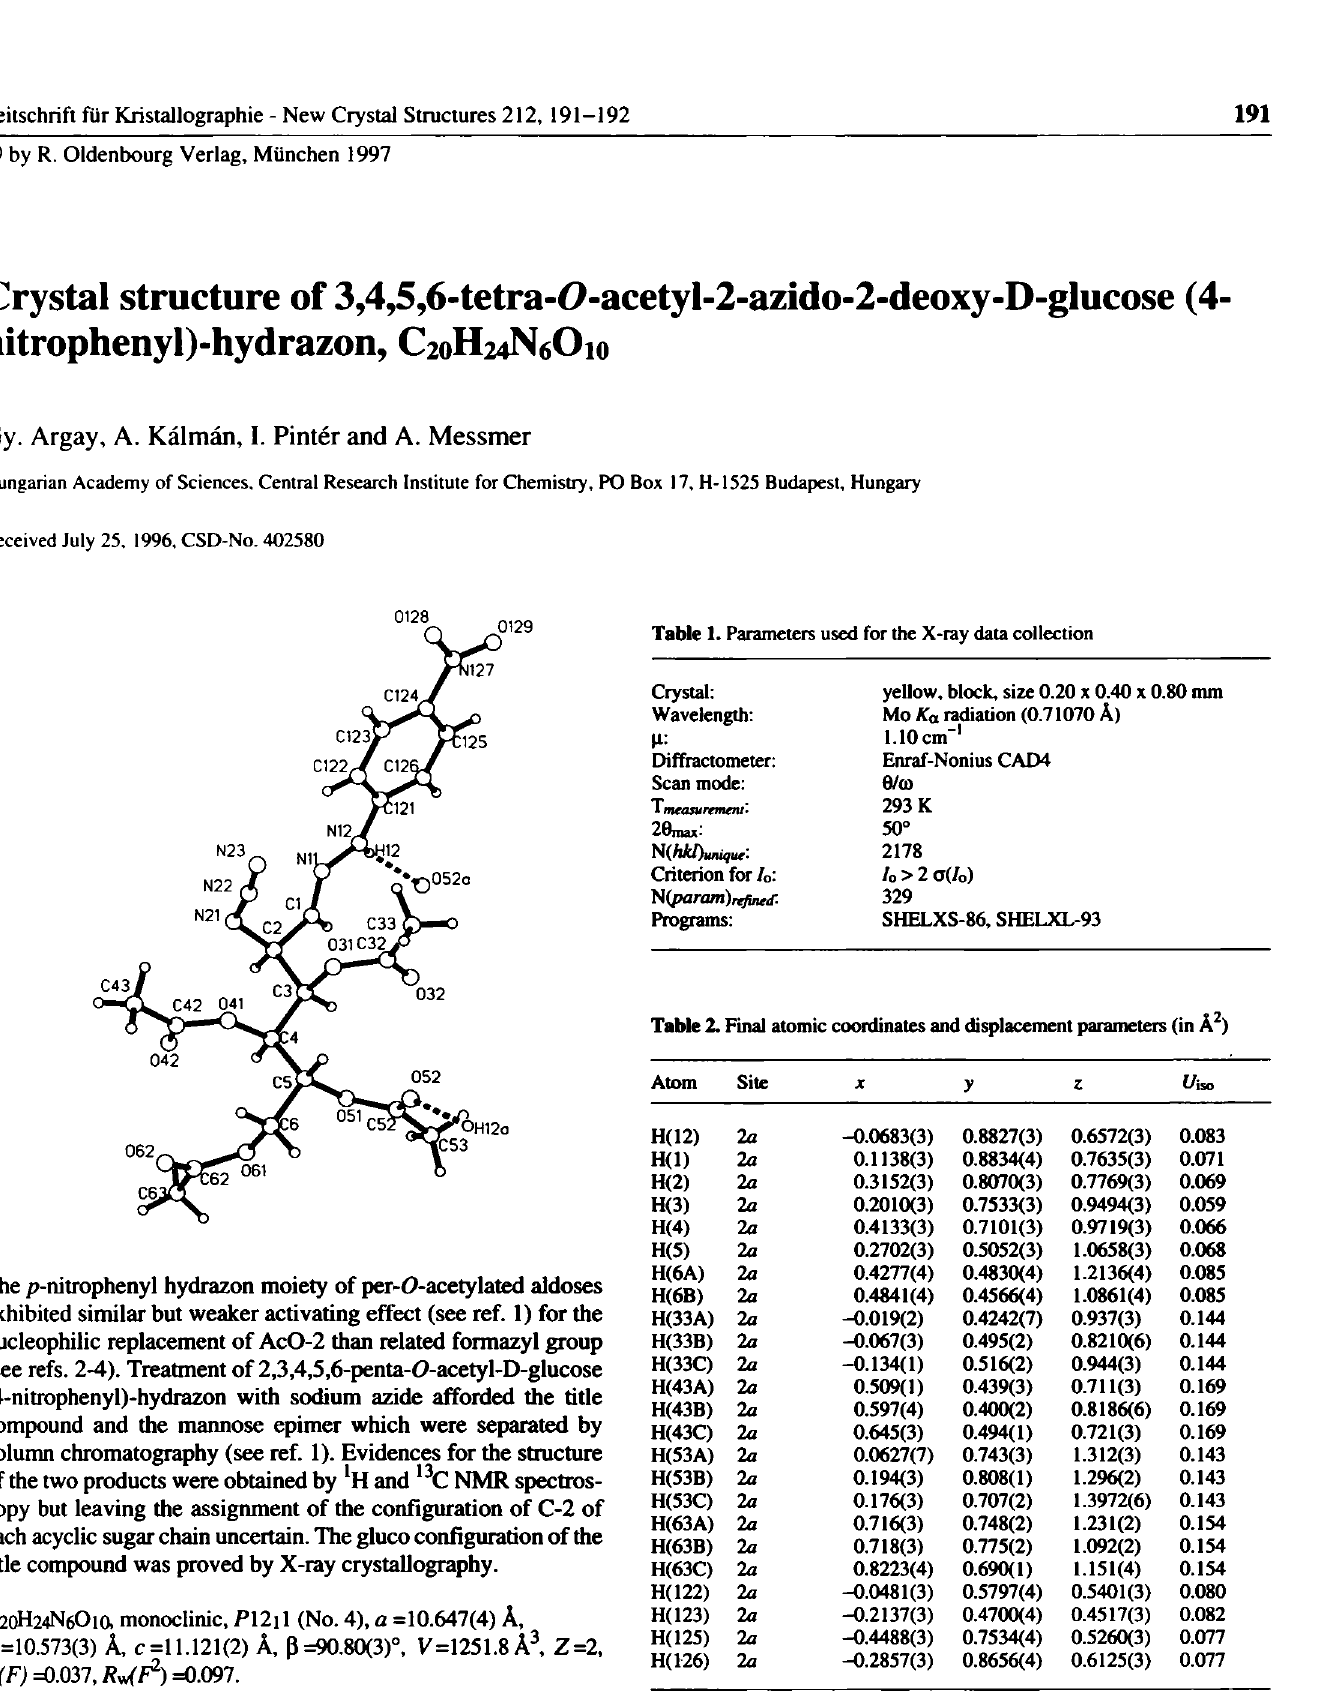
Table 3. Final atomic coordinates and displacement parameters (in Â 2 ) Atom